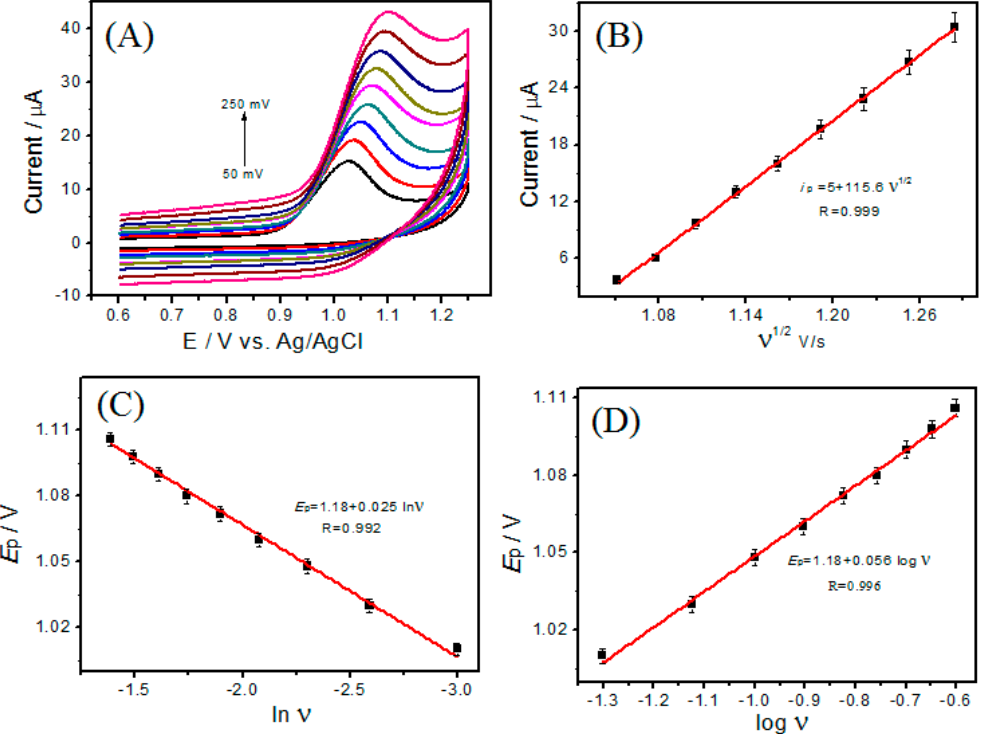
Figure 5. CVs of TiC/C with different scan rates, respectively ( A ); Dependence of peak current ( I p ) versus v 1/2 ( B ); Dependence of E p versus ln v ( C ); Dependence of E p versus log v (D).